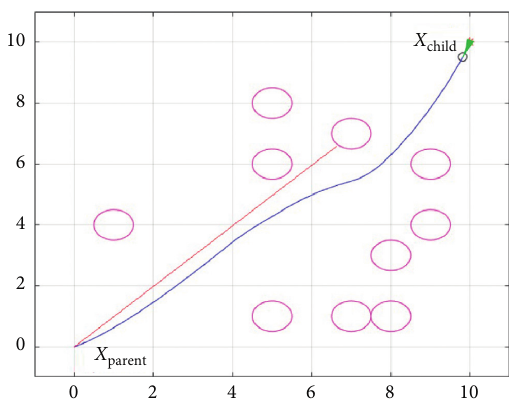
Figure 7: The intersection of global path planner and local path